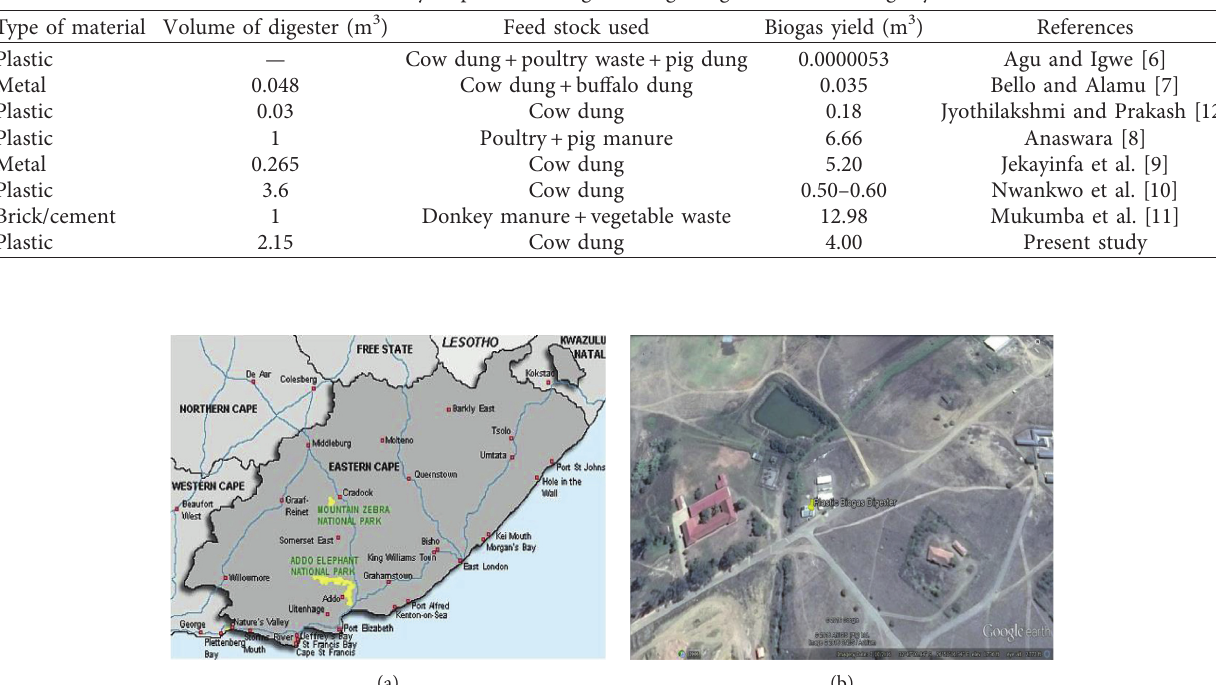
Table 1: Summary of previous design of biogas digesters with their gas yield.